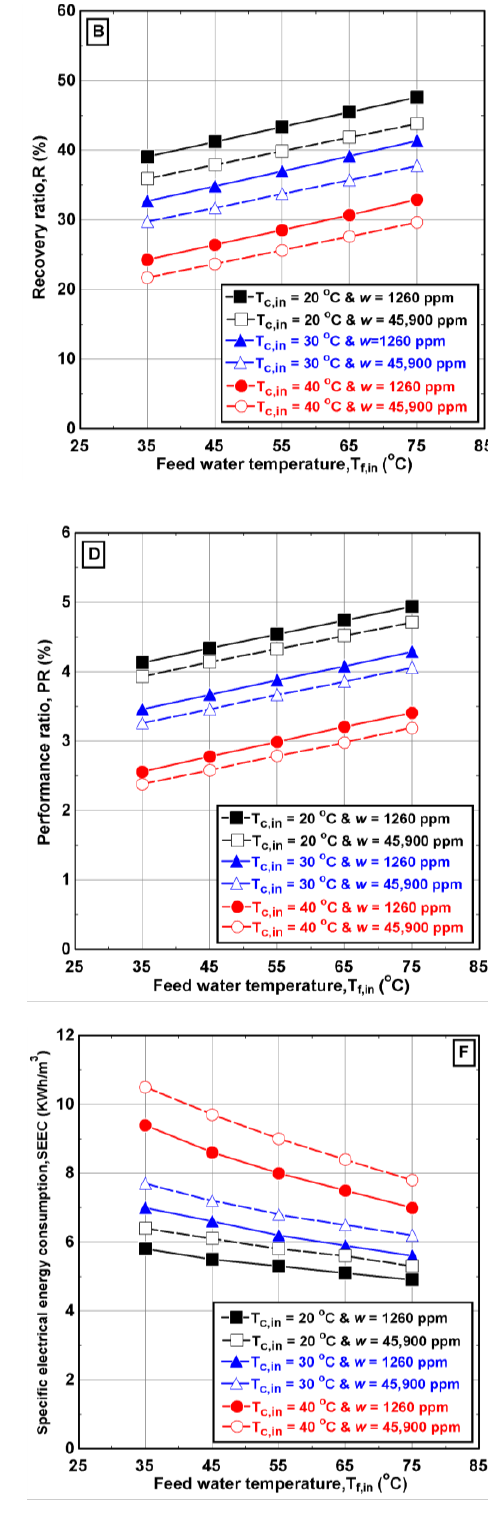
Figure 10. Effect of feed water temperature T f , in on ( A ) permeate mass flux, ( B ) recovery ratio, ( C ) gain output ratio, ( D ) performance ratio, ( E ) specific thermal energy consumption, and ( F ) specific electrical energy consumption for different cold water temperatures and salinities ( 𝑉̇ ℎ = 840 L/h, T h , in = 75 °C, 𝑉̇ 𝑐 = 405 L/h, 𝑉̇ 𝑓 = 87 L/h, and P a , vac = 115 mbar).